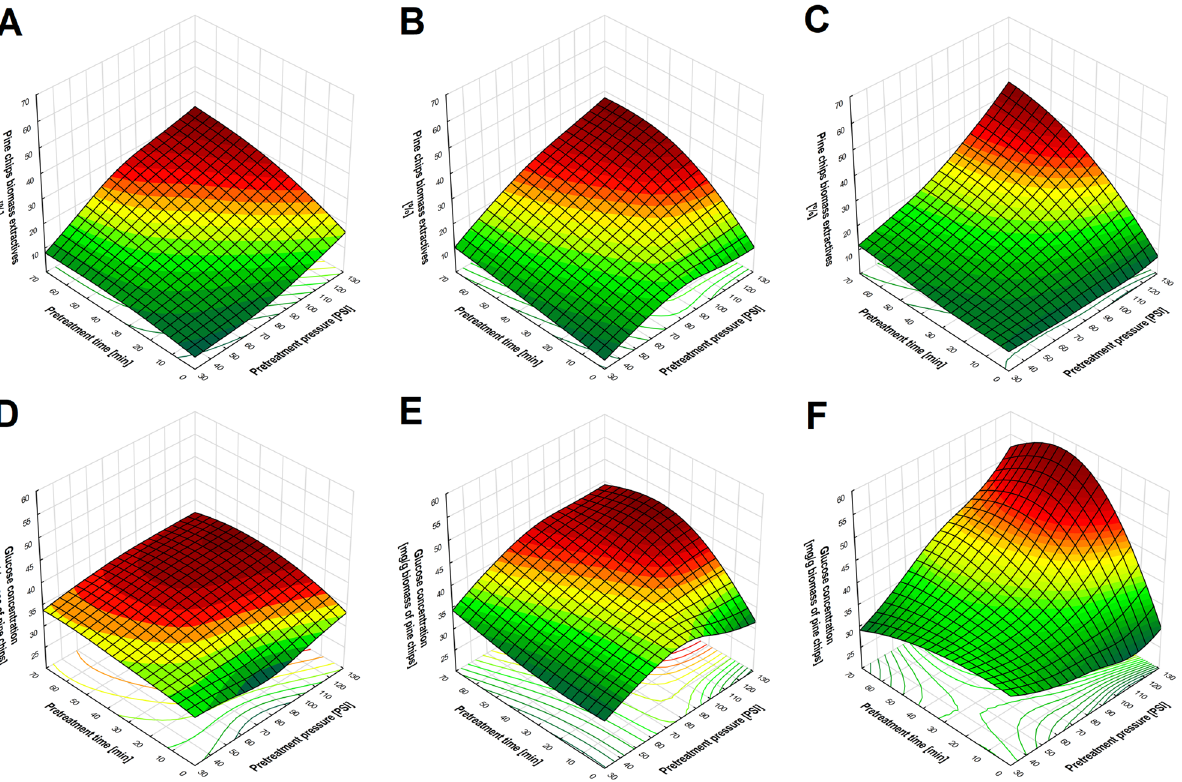
Figure 3. The effect of NaCS concentration (( A,D ) 10% w/v NaCS; ( B,E ) 20% w/v NaCS; ( C,F ) 40% w/v NaCS), pretreatment time and pressure on biomass extractives and on glucose concentration obtained by 72 h